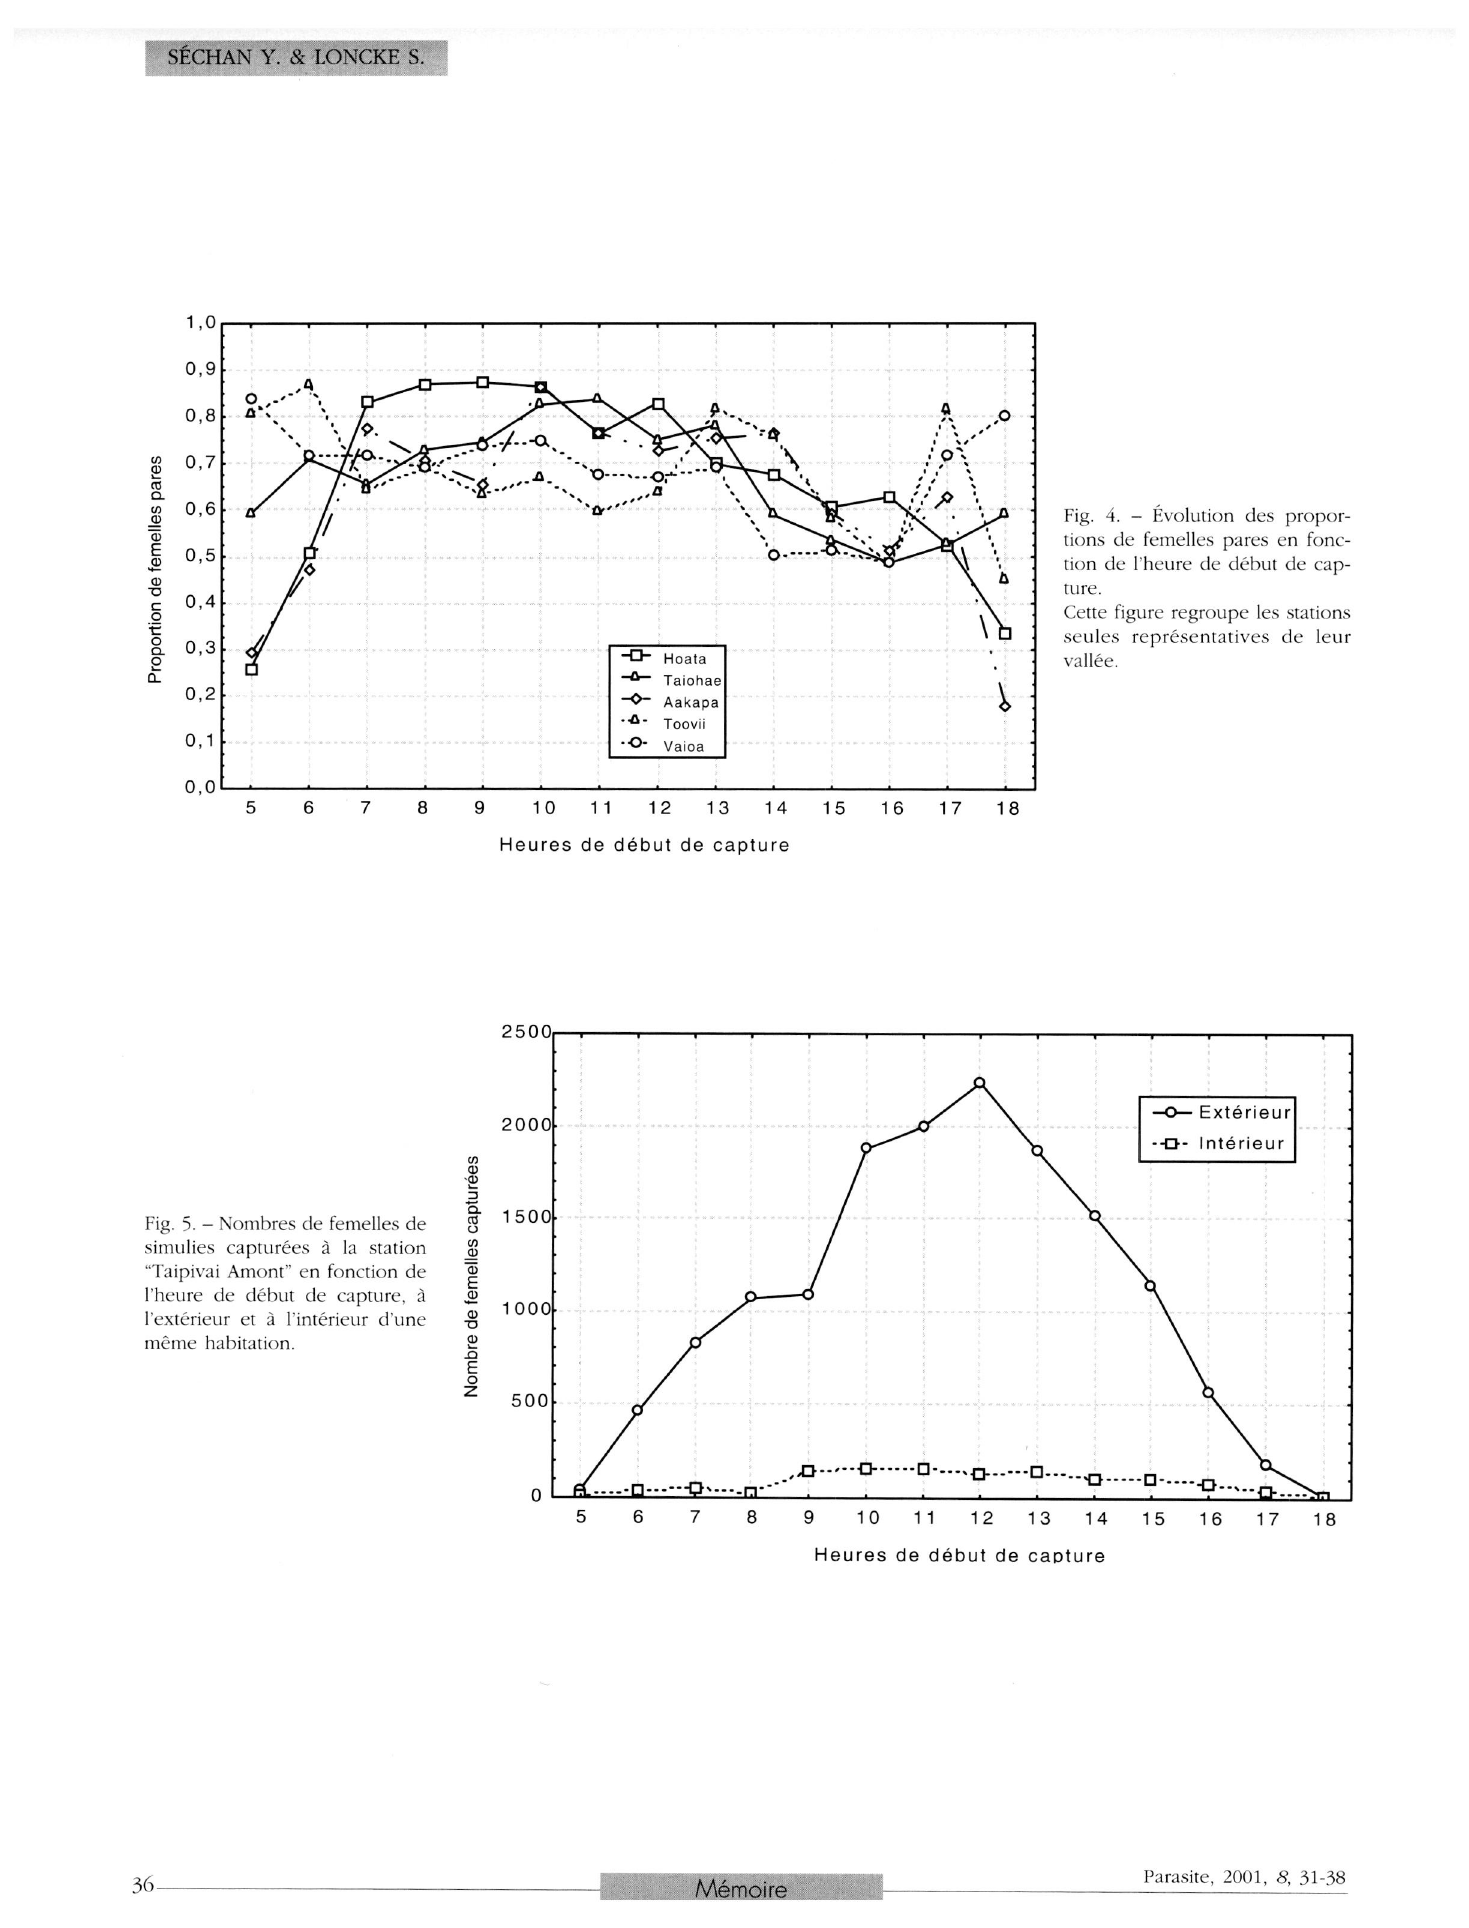
Fig. 5. - Nombres de femelles de simulies capturées à la station "Taipivai Amont" en fonction de l'heure de début de capture, à l'extérieur et à l'intérieur d'une même habitation.